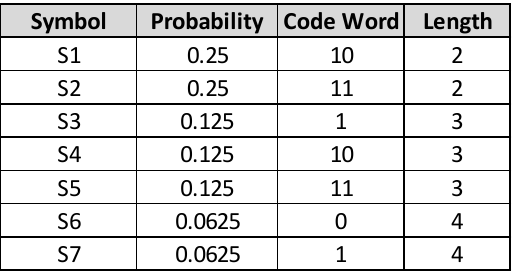
Figure 4. Huffman encoding: code